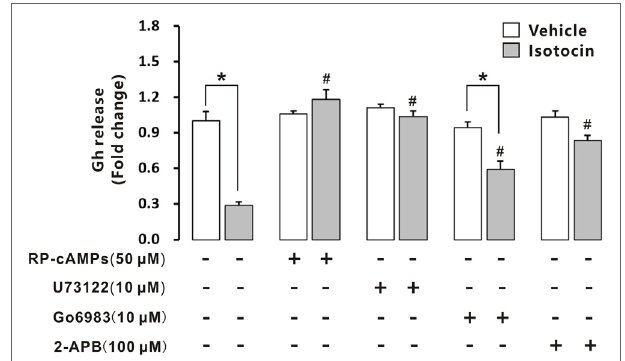
FigUre 10 | Effects of intracellular signaling pathway inhibitors on isotocin (Ist) inhibition of growth hormone (Gh) release. The primary cultured pituitary cells were pre-incubated for 12 h before being treated with Ist (100 nM) in the presence or absence of inhibitors Rp-cAMPS (50 µM), Go6983 (10 µM), U73122 (10 µM), or 2-APB (100 µM) for 12 h, respectively. After drug treatment, the culture medium was harvested for measurement of Gh release by competitive ELISA. Data were expressed as fold change relative to the vehicle control in the absence of inhibitors. Bars represent mean ± SEM of pooled results from four separate experiments ( n = 4). * P < 0.05 between the indicated groups, # P < 0.05 vs. the group treated only with isotocin (one-way ANOVA followed by the turkey